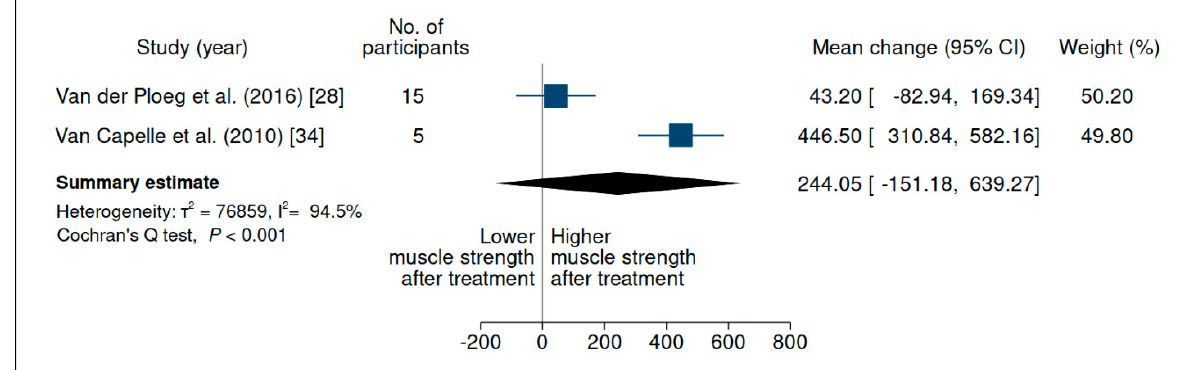
Figure 4. Evaluation of handheld dynamometry in patients with late-onset Pompe disease on enzyme replacement therapy with alglucosidase alfa. Weights are inverse-variance weights and are proportional to the contribution of each study to the summary estimate. I² is the fraction of variance that is due to statistical heterogeneity and not chance. Tau² denotes the between-study variance.